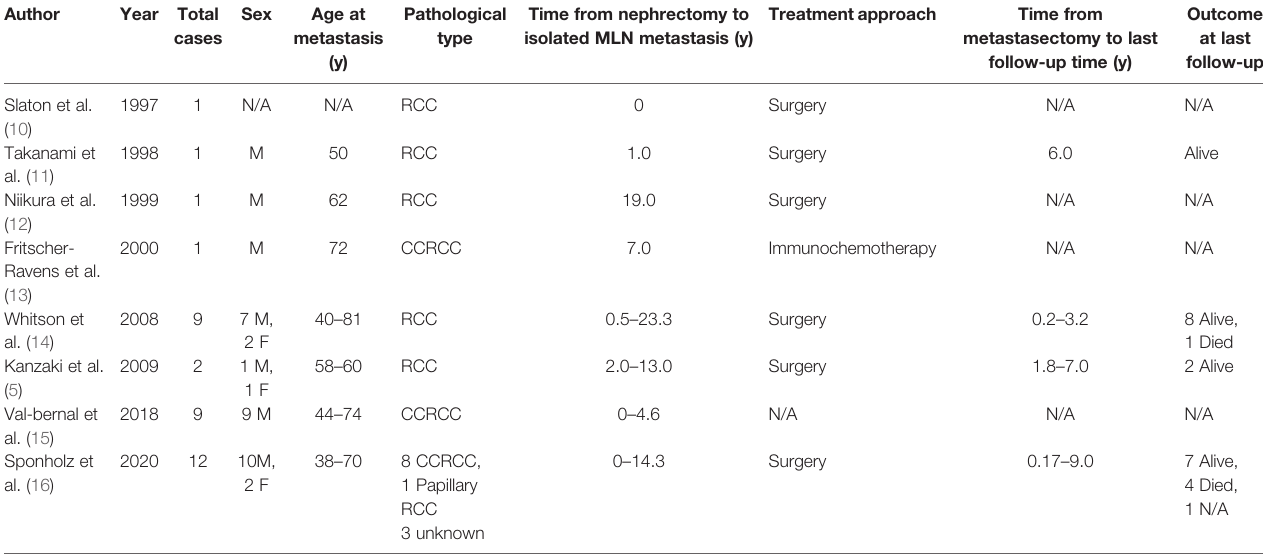
TABLE 1 | Cases published in the literature on metastatic RCC to the MLN solely.